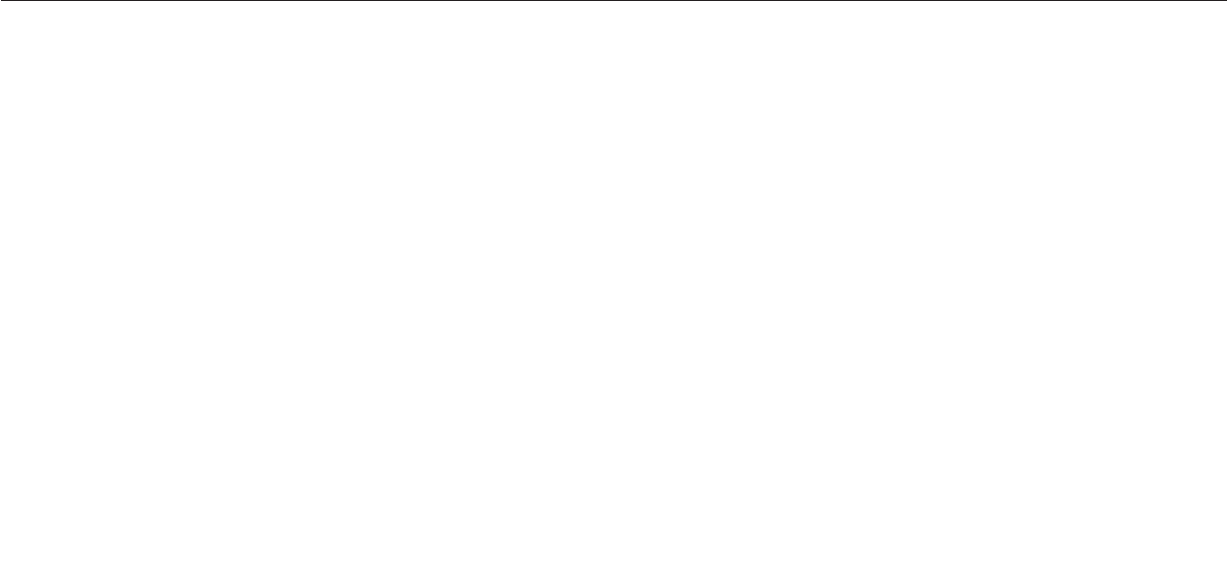
FIGURE A1 | This figure shows the slice regions (in blue) for all four unilateral neglect